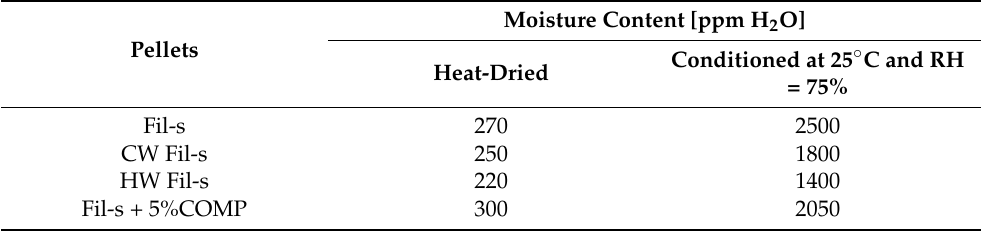
Table 2. Moisture contents of heat-dried and not-dehumidified Fil-s based systems.